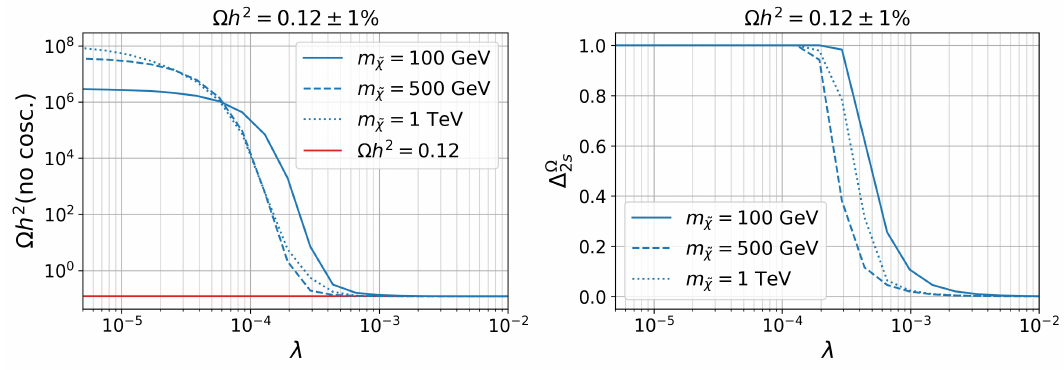
Figure 8: As Fig. 7 but showing on the left Ω h 2 ( 2 sectors, no co-scattering ) and on the right the corresponding ∆ Ω